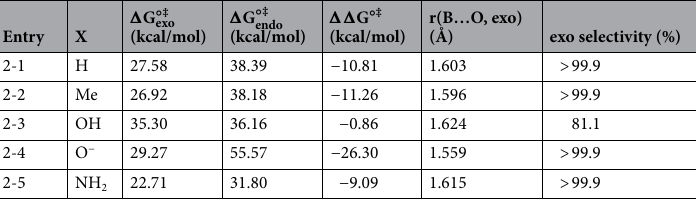
Table 3. Results of the DFT calculations on the TSs of the five DA reactions outlined in Fig. 4.